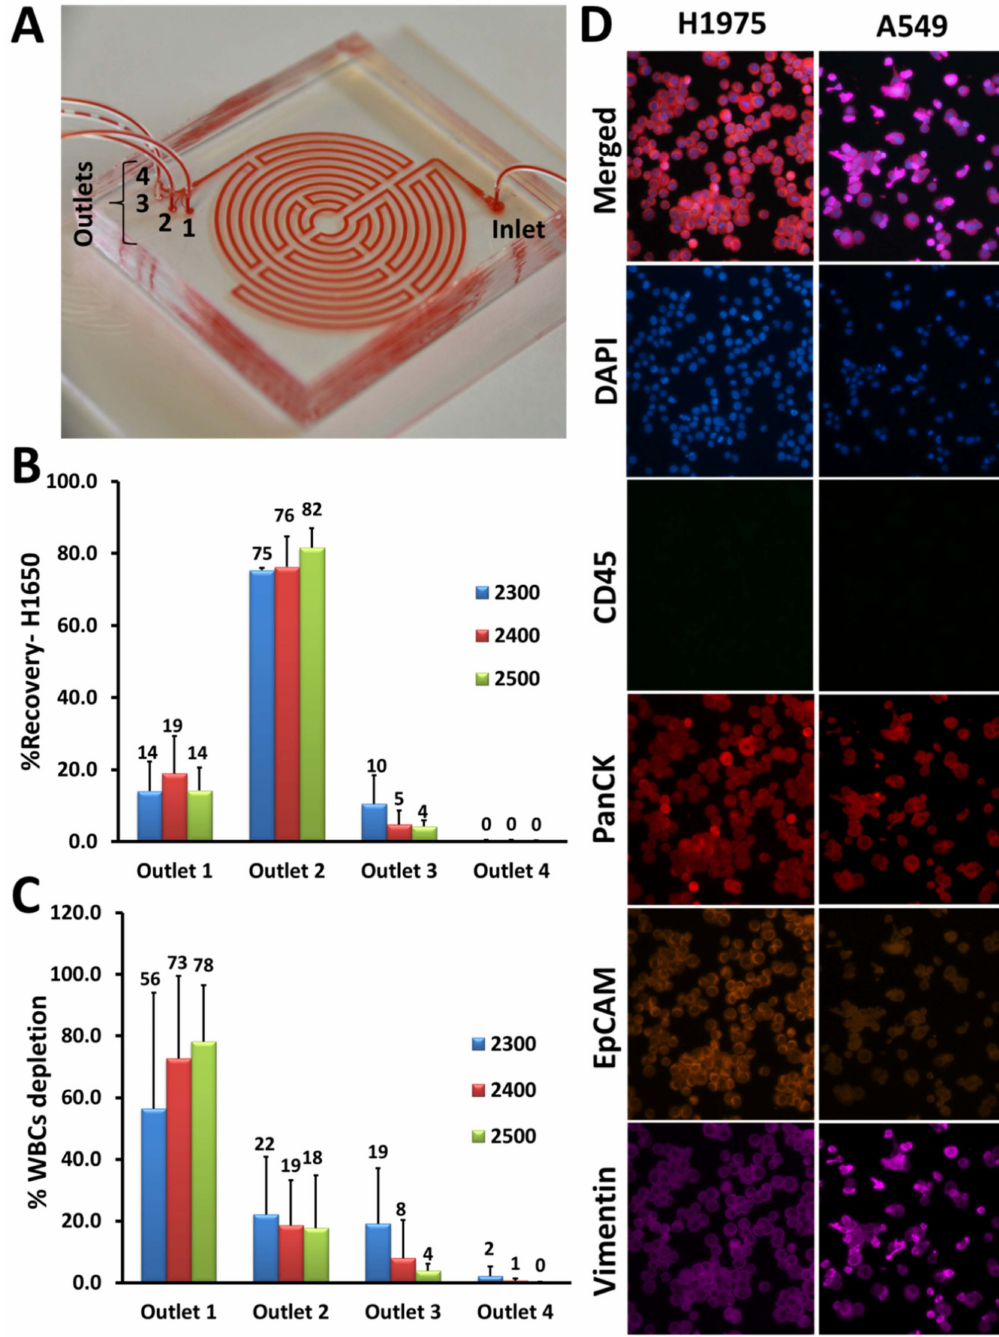
Figure 1. Optimization of Labyrinth for cell recovery. ( A ) The Labyrinth was loaded with red dye to show the device’s structure as well as the inlet and outlets. ( B , C ) Using the H1650 lung cancer cell line, di ff erent flow rates ranging from 2300–2500 µ L / min were tested for inertial separation of cancer cells. Pre-labeled H1650 cell line and DAPI (4 (cid:48) ,6-diamidino-2-phenylindole)-labeled white blood cells (WBCs) (1000 cells) were spiked into PBS and processed through the Labyrinth. Using a flow rate of 2500 µ L / min, 82% ± 5% of H1650 cells were recovered from outlet #2 and 78% ± 18% of WBCs were removed through outlet #1. ( D ) Immunofluorescence staining optimization. Anti-human CD45 (cluster of di ff erentiation 45) (green), anti-human PanCK (pan-Cytokeratin) (red), anti-human EpCAM (Epithelial cell adhesion molecule) (orange), and anti-human Vimentin (pink) antibodies were tested with lung cancer cell lines, H1975 and